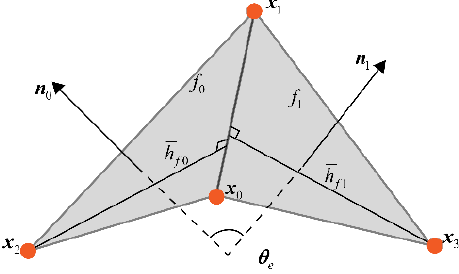
Figure 8. Illustration of the two connected units.